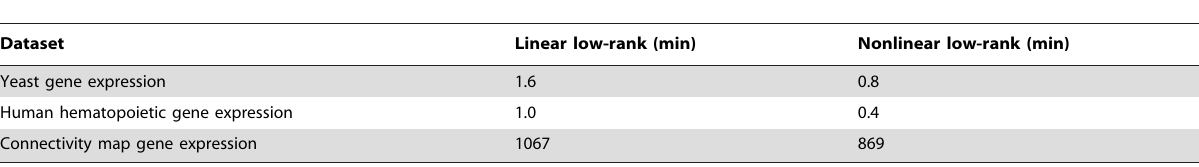
Table 4. CPU time of running the linear and nonlinear low-rank